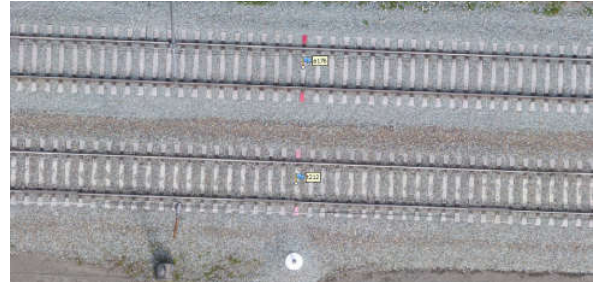
Figure 5. A fragment of an orthophotoplan with control points placed by